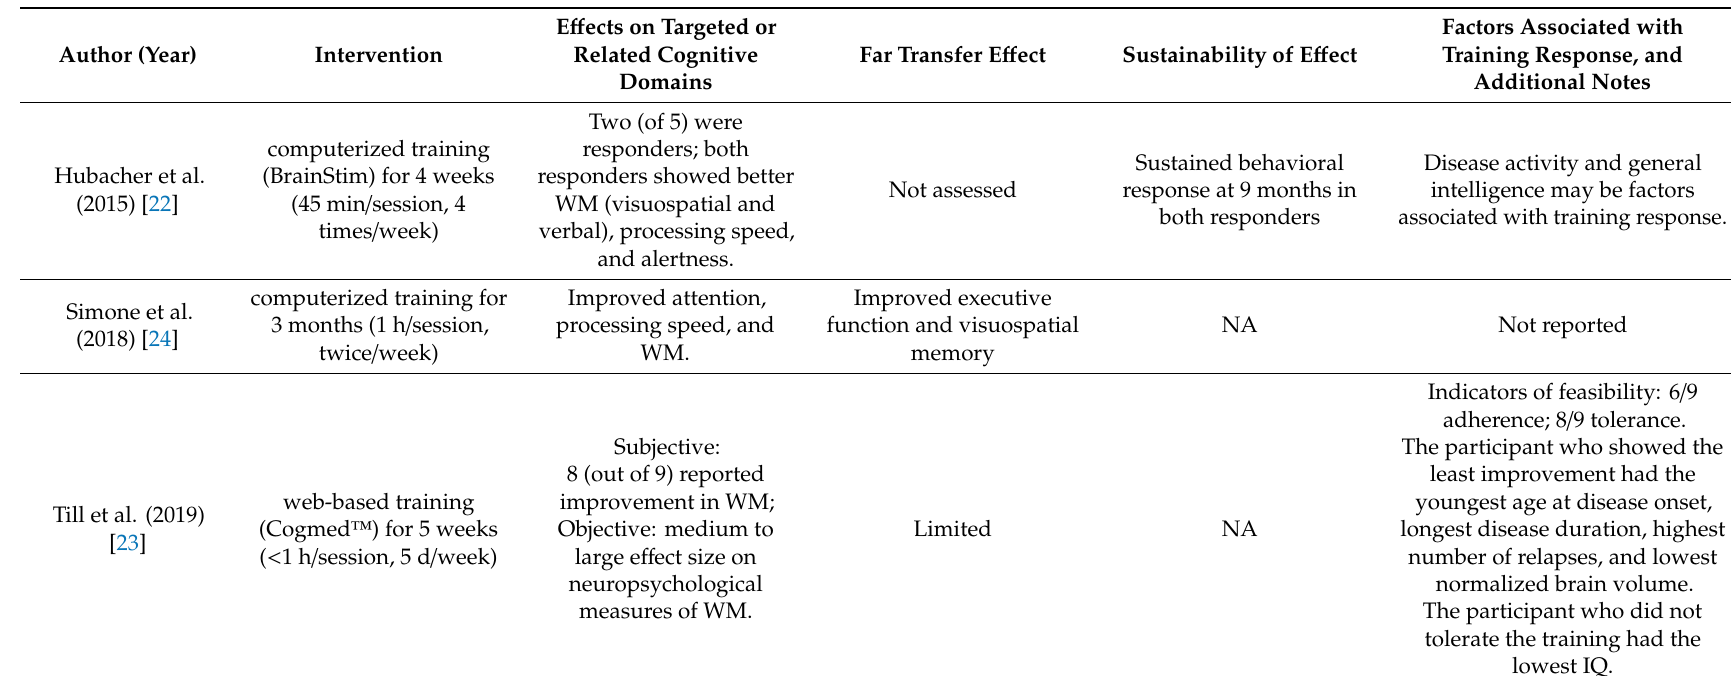
Table 3. Original studies evaluating cognitive rehabilitation for POMS: Summary of